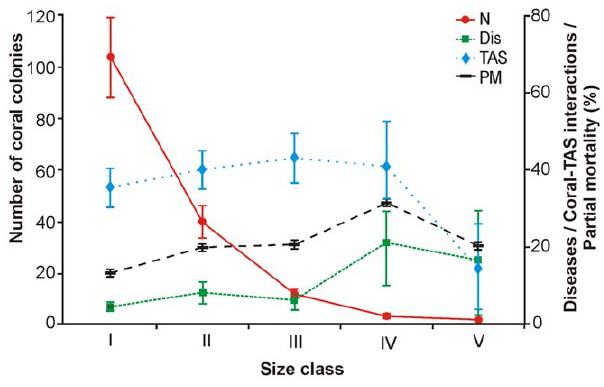
Figure 1. Coral colonies, diseases (%), coral-TAS mats compet- itive interactions and partial mortality in relation to size. Number of coral colonies (N), percentage of colonies with disease signs (Dis) and involved in a competitive interaction with turf-algal sediment mats (TAS) and percent colony mortality (PM) per transect (N=10) in relation to size class (I: 0 to 10 cm diameter, n=1037 colonies, II: . 10 to 20 cm, n=400 colonies, III: . 20 to 30 cm, n=104 colonies, IV: . 30 to 40 cm, n=28 colonies, V: . 40 cm, n=12 colonies) at Xcaret in 2005. Means 6 Standard Error.